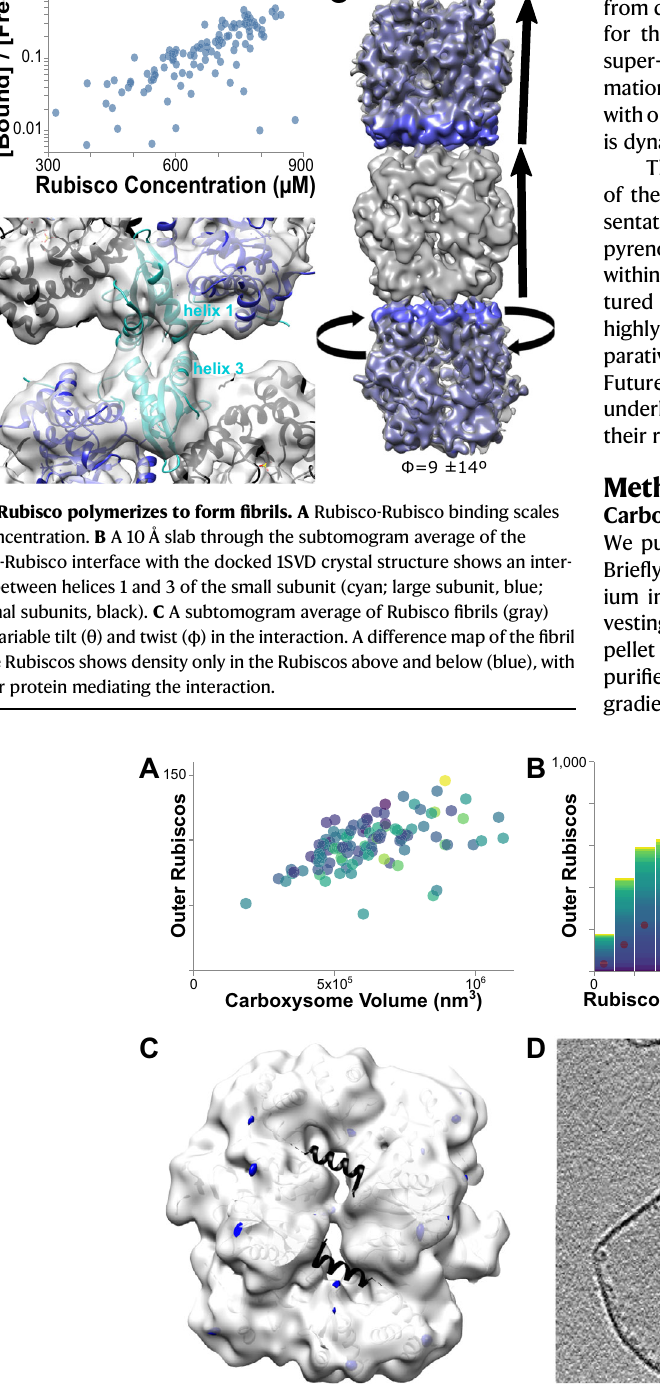
layer. White: C1 interior Rubisco subtomogram average (3nm slab, fi ltered). Blue: difference map showing density added in the outer layer Rubisco subtomogram average. Black: 6UEW crystal structure with CsoS2 peptide. D A 4.4nm-thick orthoslice of shell-associated density in broken shells. Red arrow, example unas- signed protein density; cyan arrow, Rubisco. Scale bar 50nm.